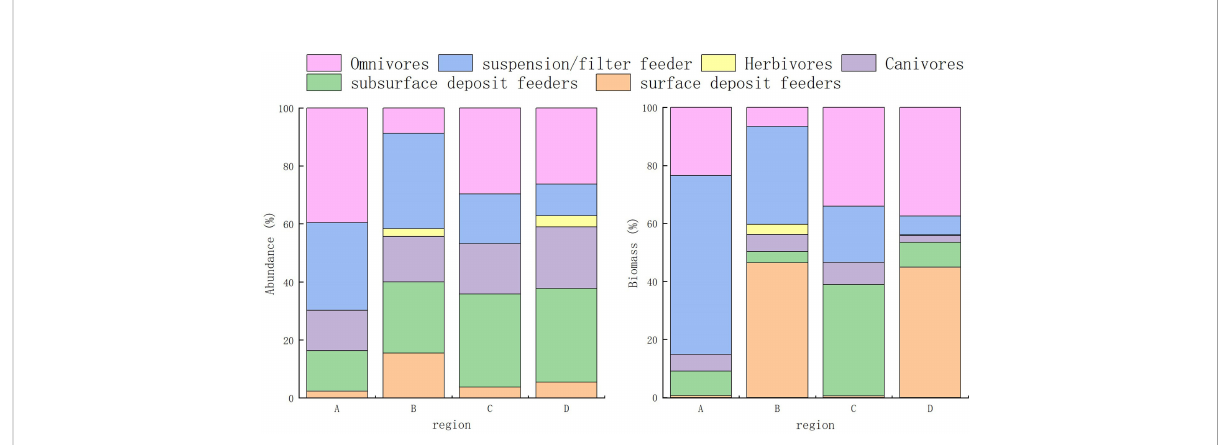
FIGURE 6 Proportional abundance and biomass of macrobenthos feeding guilds throughout Hangzhou Bay.